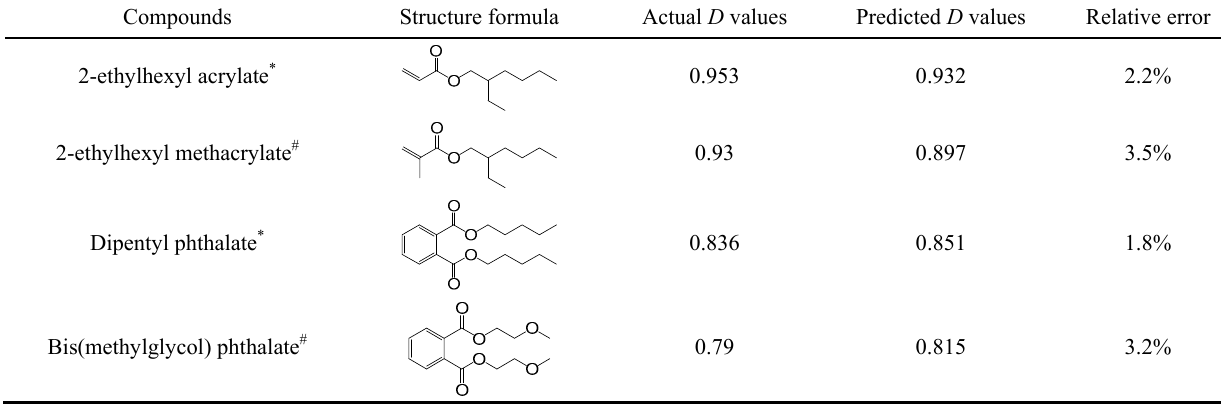
Table 2 Comparison of the structure and D values of the two new compounds and their reference compounds.